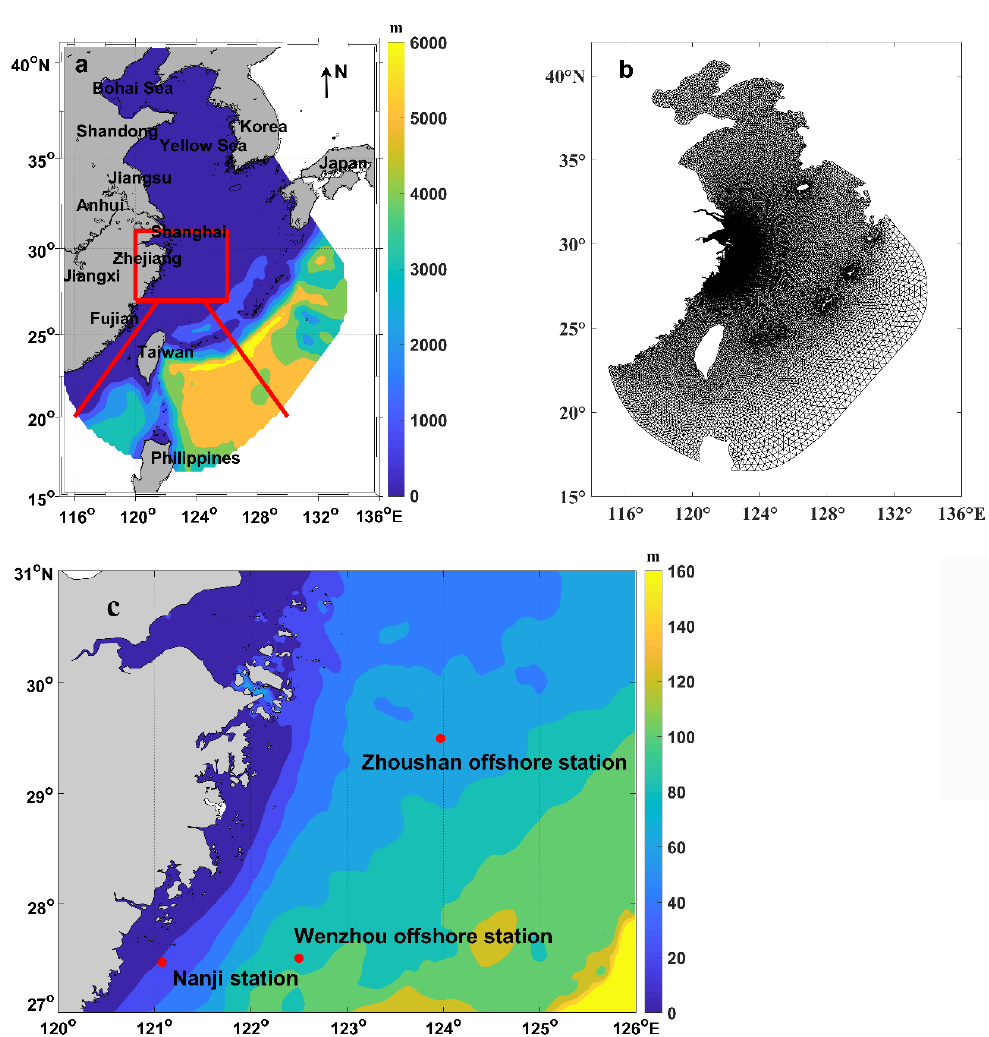
Figure 1. ( a ) Model domain and bathymetry; ( b ) Computational grid of the model; ( c ) Location of Nanji station, Wenzhou offshore station, and Zhoushan offshore station. The range of ( c ) is marked with a red rectangle in ( a